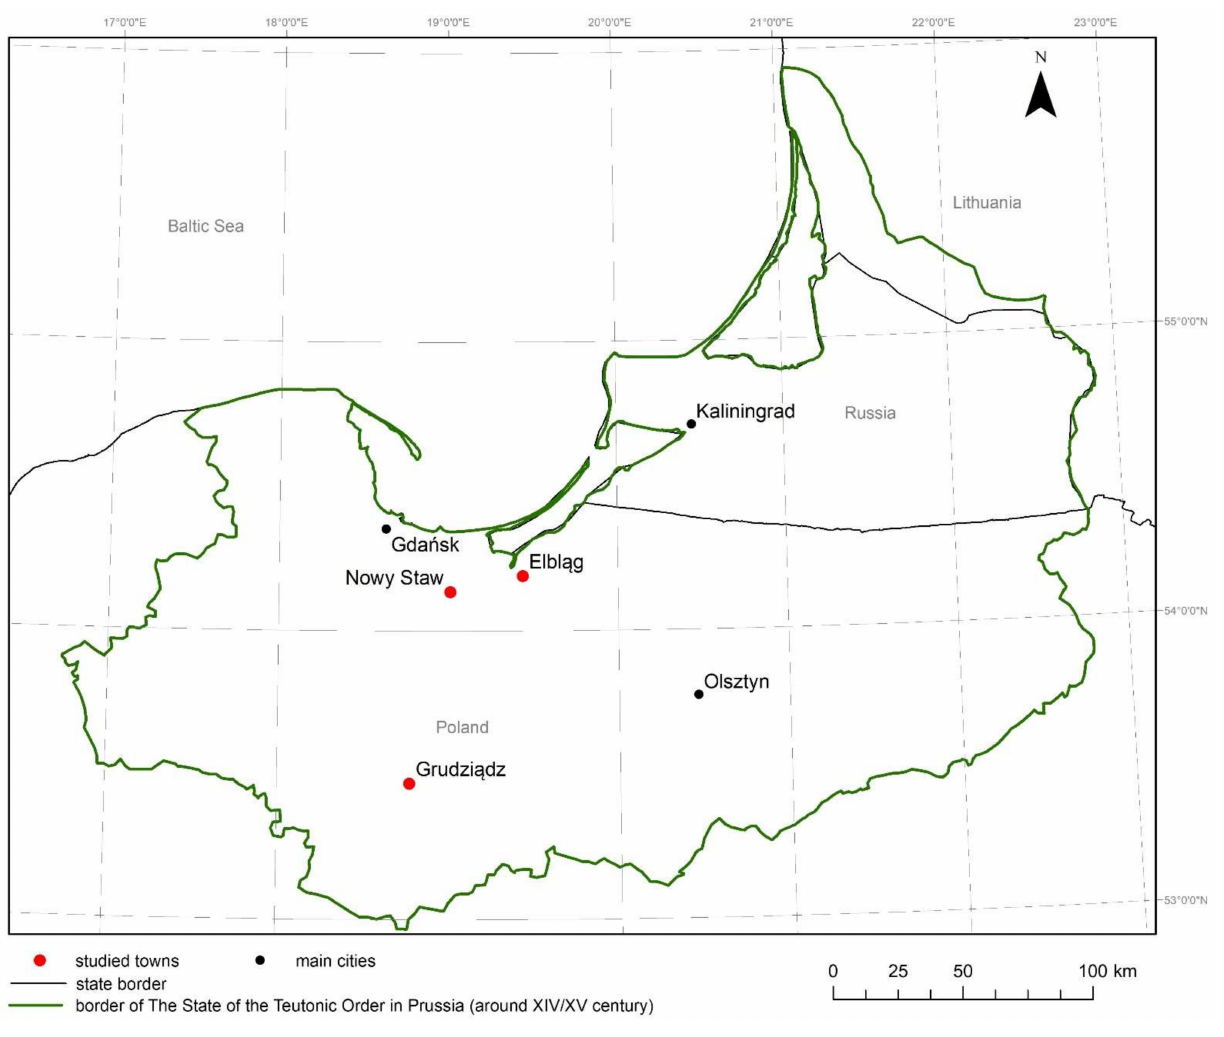
Figure 2. Location of the study area [48]. Table 1. Characteristics of cartographic materials and sources used in the